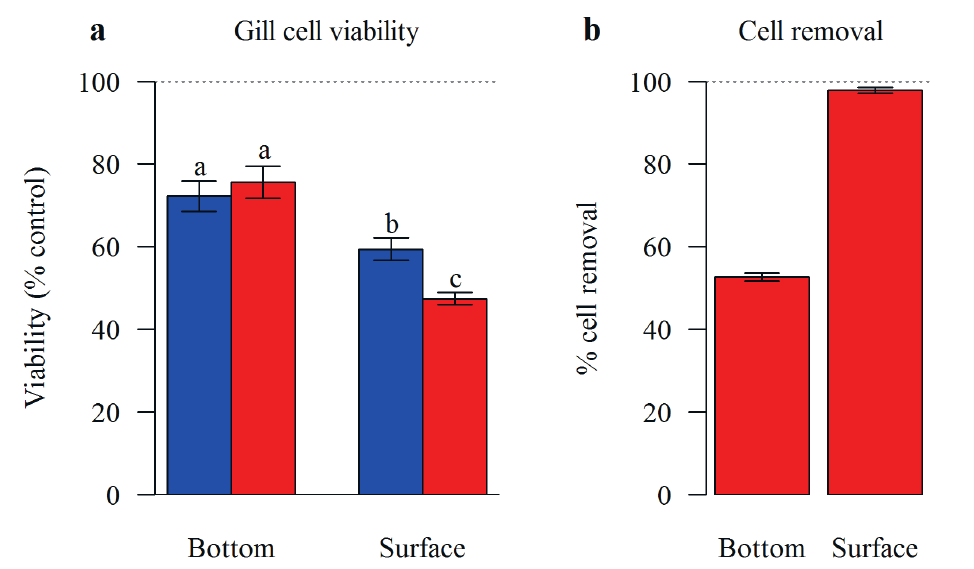
Figure 2. ( a ) Gill cell viability after exposure to high density (surface: 7.6 × 10 5 ; bottom: 9.8 × 10 5 cells mL − 1 ), high pH (9.8) P. parvum cultures treated with